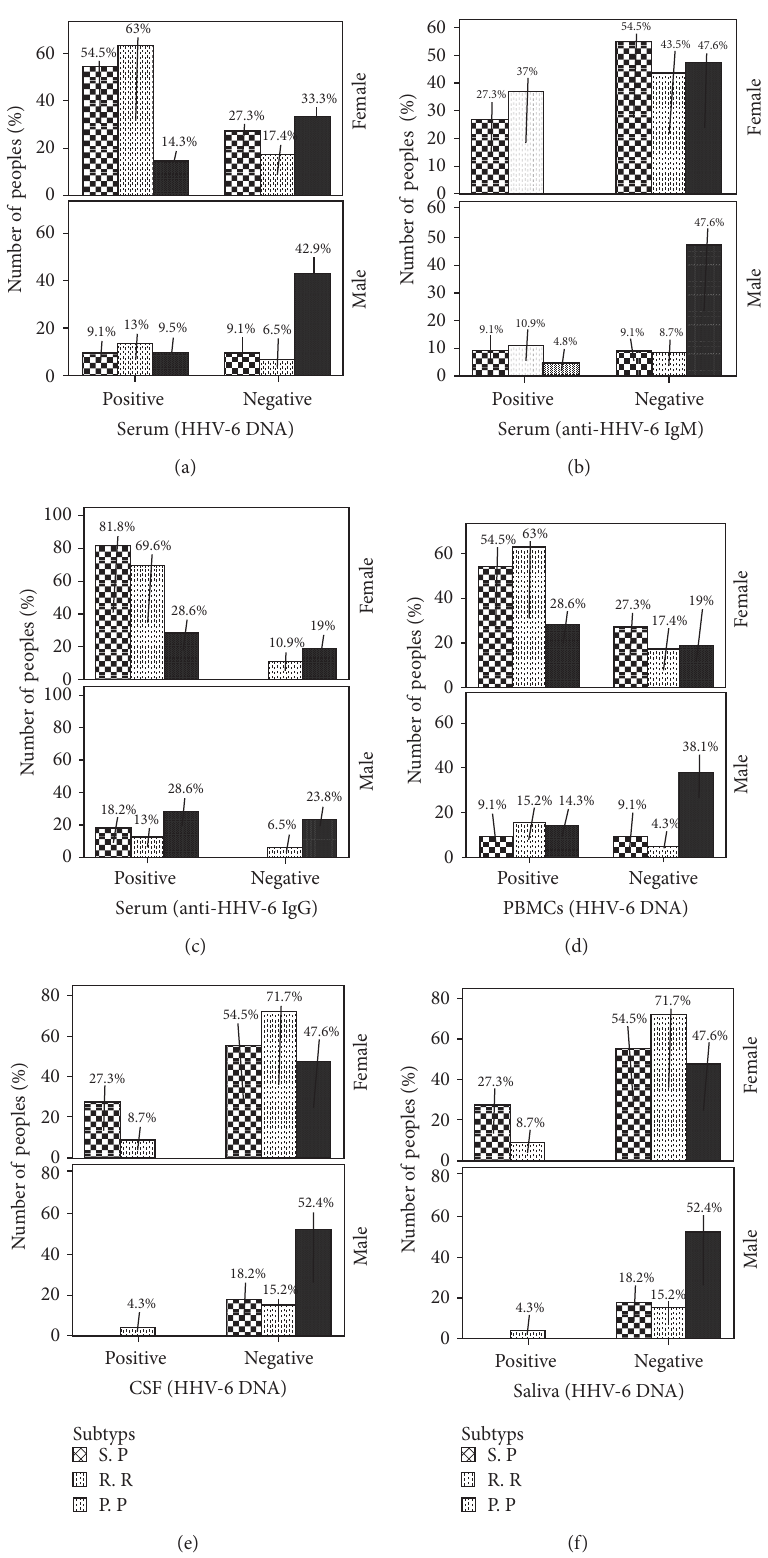
F 2: Prevalence of HHV-6-DNA and antibodies among male and female in different subtypes of